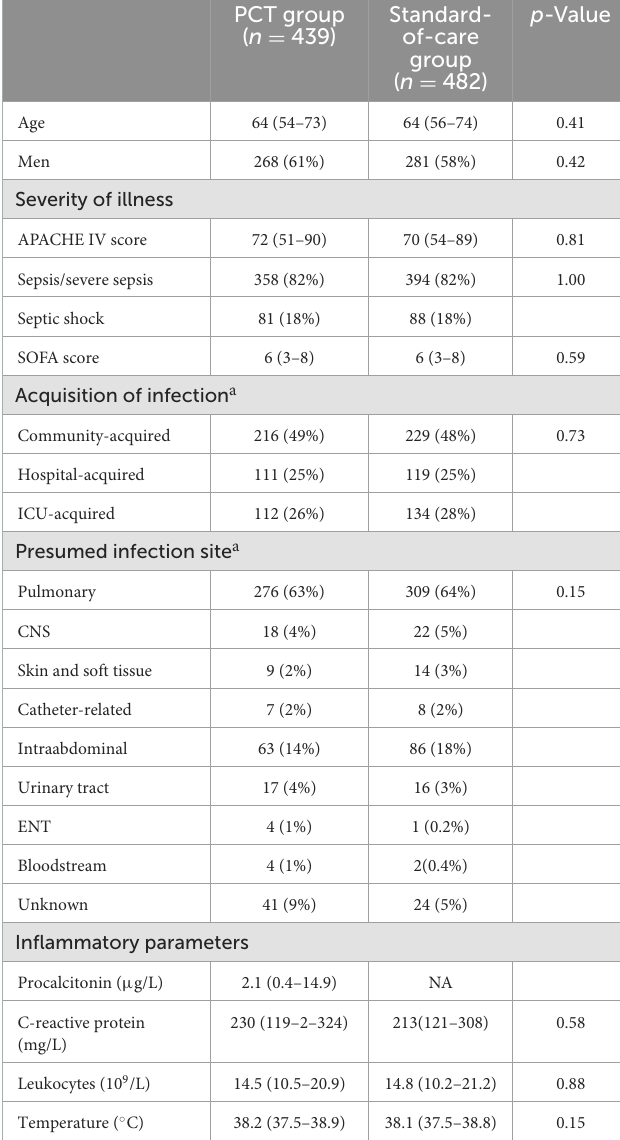
Comparisonofpatientcharacteristicsatthetimeofrandomizationtoprocalcitonin-guidegroup (PCT)orcontrolgroupthatreceivedstandard-of-care. Medians with (IQR) or numbers with (percentages) APACHE-IV, acute and chronic health evaluation IV score; SOFA, sequential organ failure score; CNS, central nervous system; ENT, earnoseandthroat;ICU,intensivecareunit. a Duetorounding,percentagesmaynotalwaysaddupto100%.